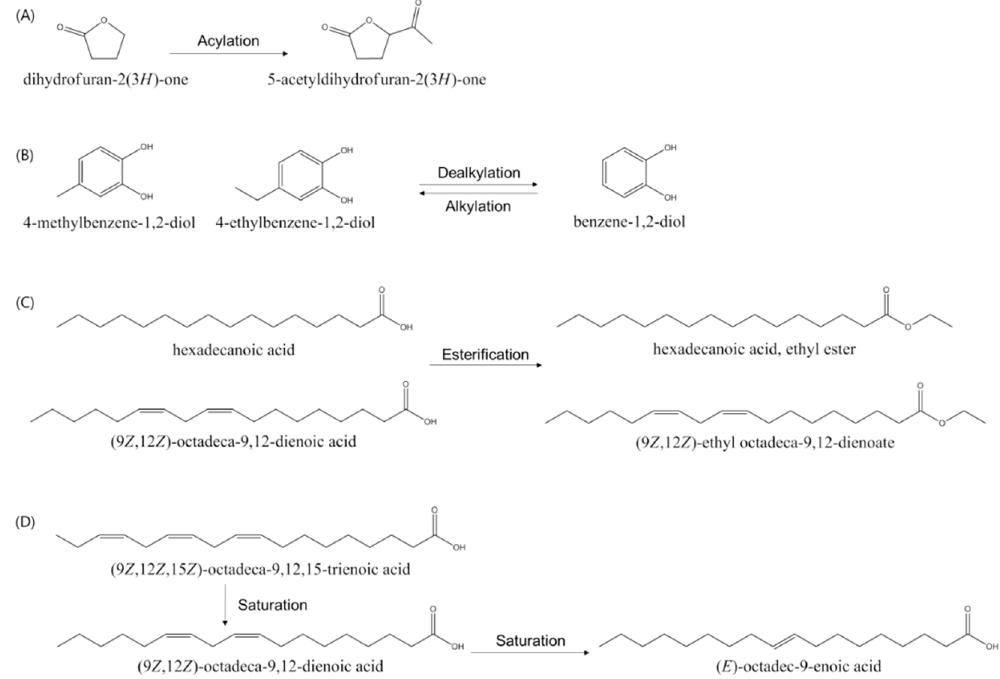
Figure 3. Proposed reaction of bioactive compounds of S. miltiorrhiza ethanol extracts during fermentation. ( A ) acylation; ( B ) dealkylation and alkylation; ( C ) esterification; ( D ) saturation.